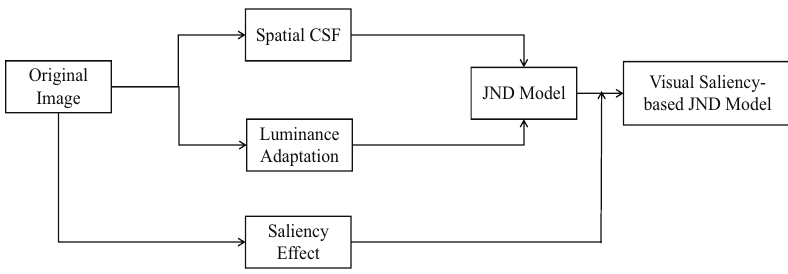
Figure 1. The visual saliency-based JND